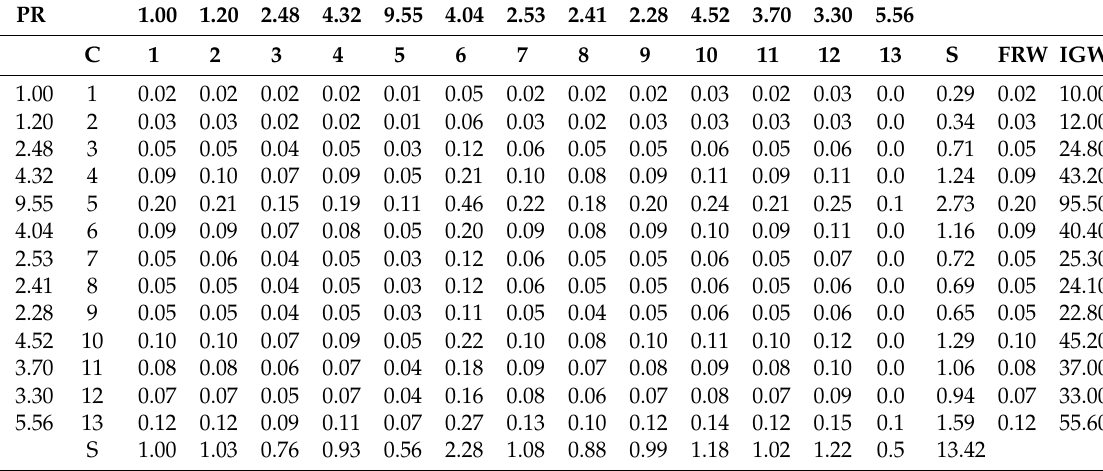
Table 4. Eigenvalues and integer weights of the predisposing factors of landslide susceptibility.